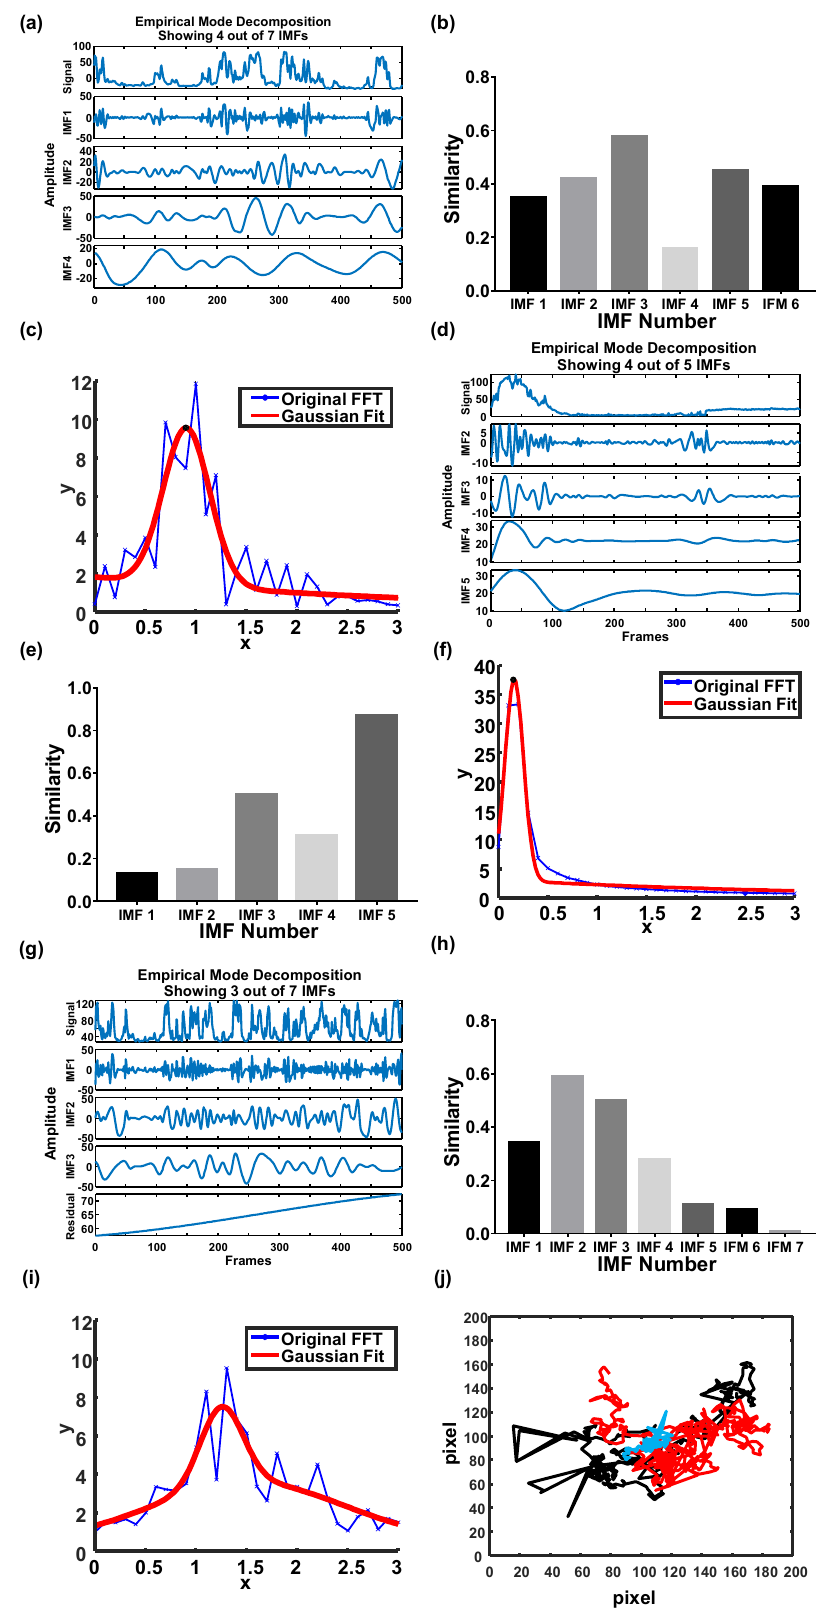
Figure 6. EMD, similarity of IMFs, and blinking frequency of particles under different conditions. ( a – c ) The EMD, similarity of IMFs, and blinking frequency of particles under 0% glycerol at 25 ◦